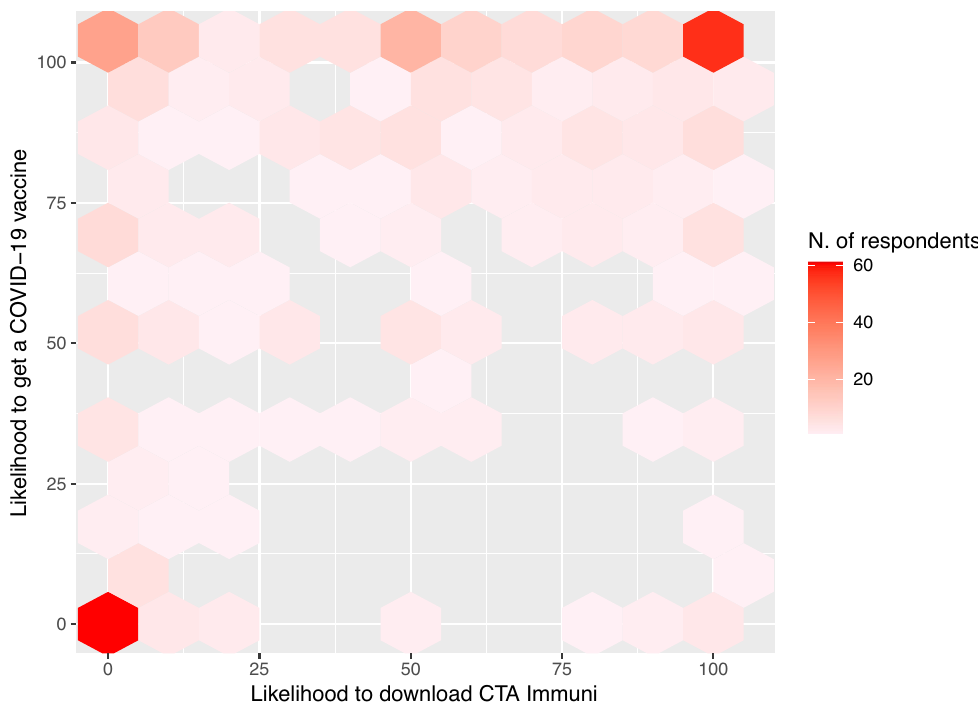
Figure 2. Joint distribution of the likelihood to get a COVID-19 vaccine and to download CTA